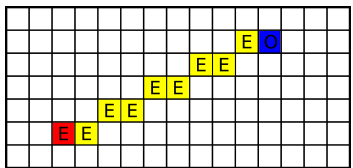
Figure 3. Sensor model. The robot (the red cell) measures an obstacle at the blue cell. The numbers in the cells represent sensor model values.